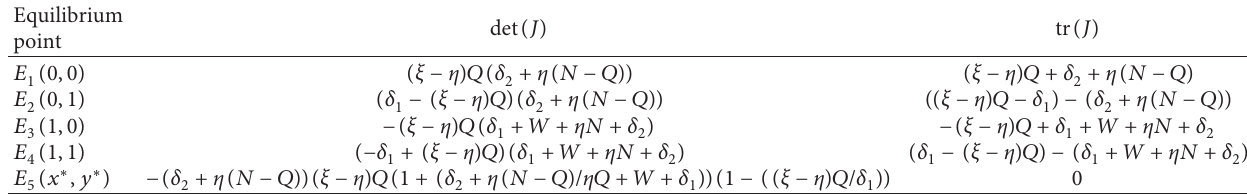
Table 2: The definitions of det ( J ) and tr ( J ) of each equilibrium point.